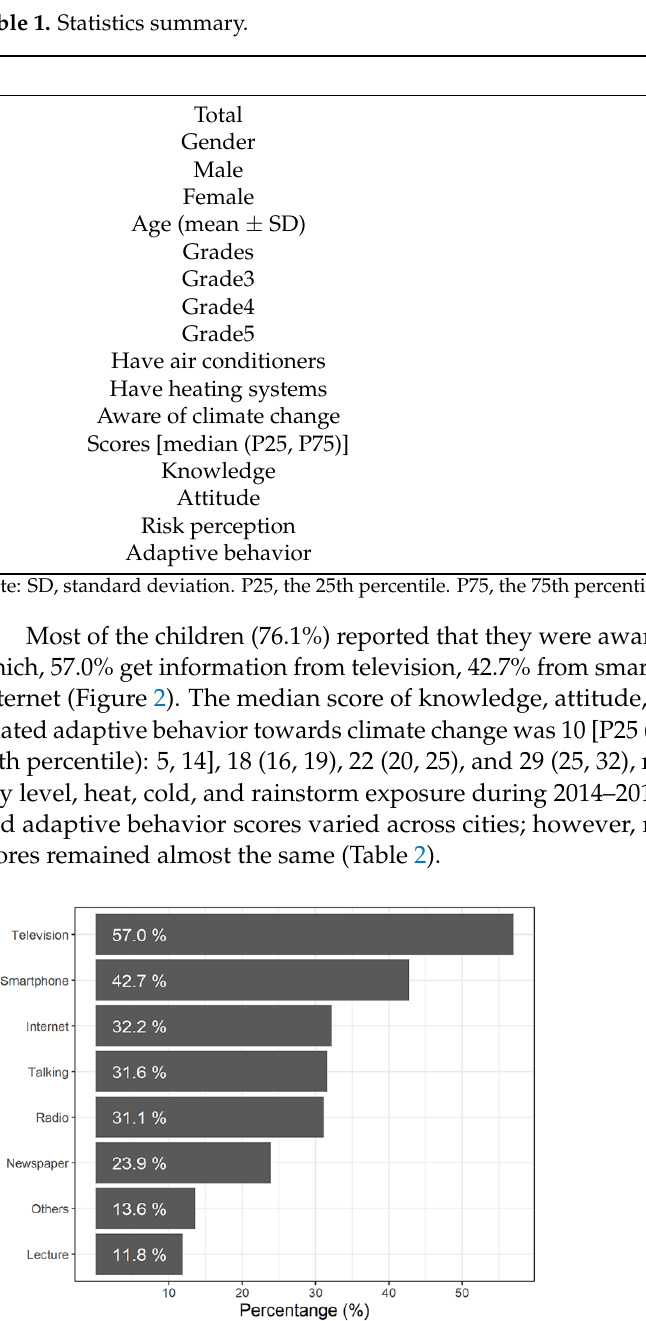
Figure 2. Sources of information about climate change.